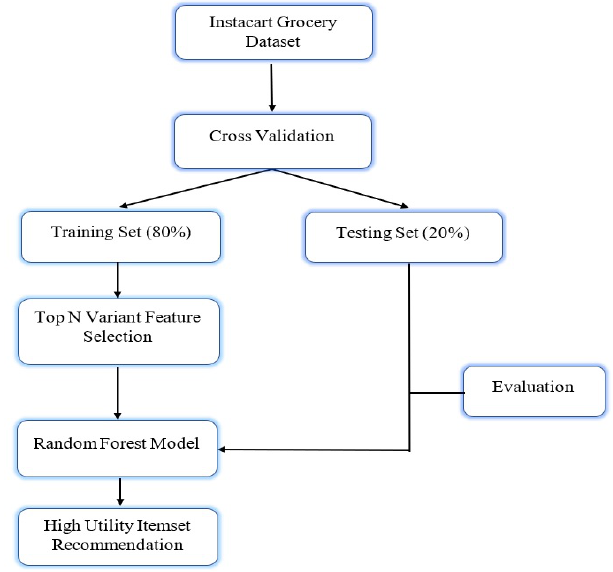
Figure 1. Overall flow of Top N variant Random Forest